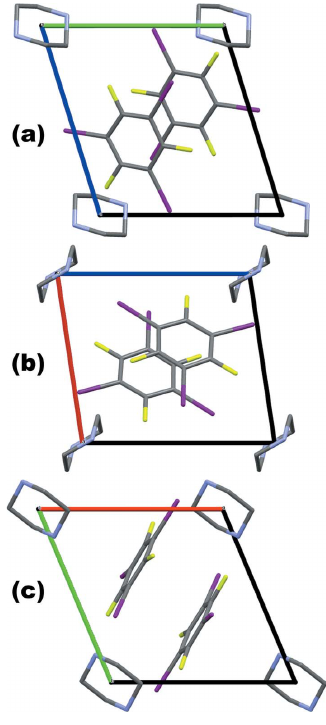
Figure 3 View along each of the unit cell axes. ( a ): along the a axis; ( b ): along the b axis; ( c ): along the c axis. Hydrogen atoms not shown.